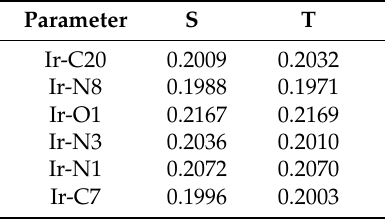
Table 1. Bond lengthes (nm) ‐ S, bond angles (°C) ‐ T.